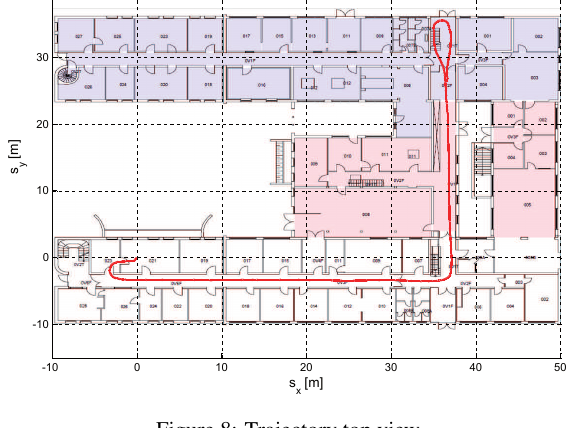
Figure 8: Trajectory top view